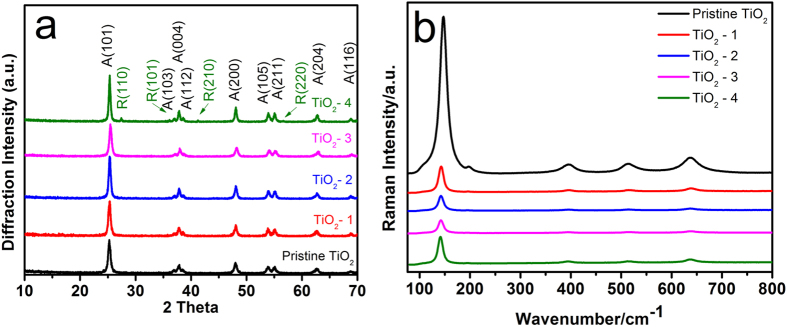
(a) Representative XRD pattern and (b) Raman spectra of the pristine TiO2 and as-synthesized TiO2.